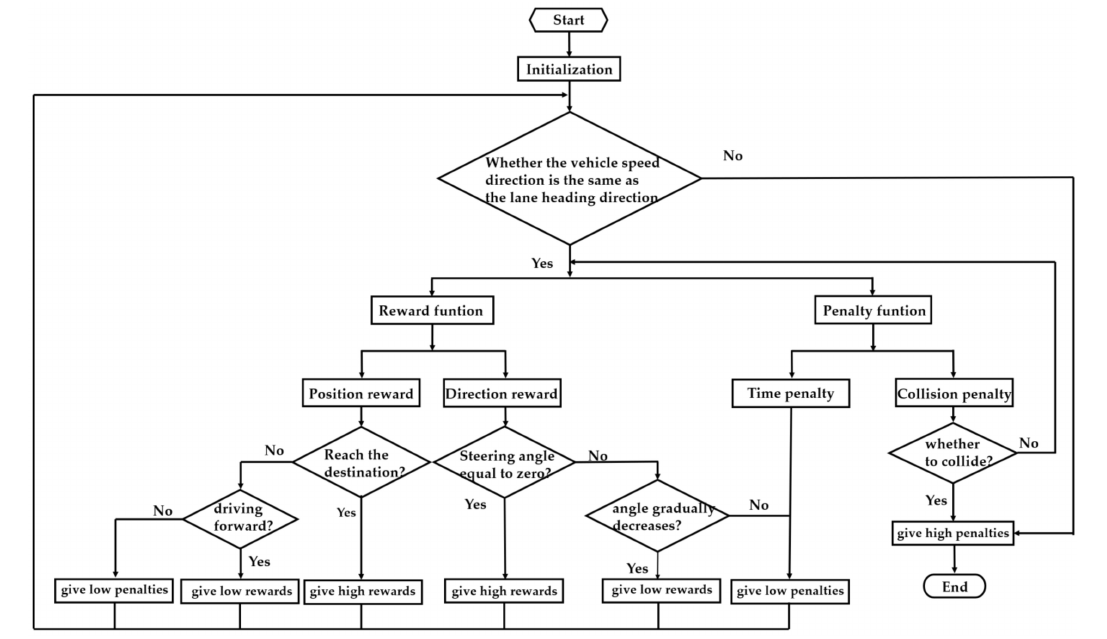
Figure 10. Logic diagram of reward function.